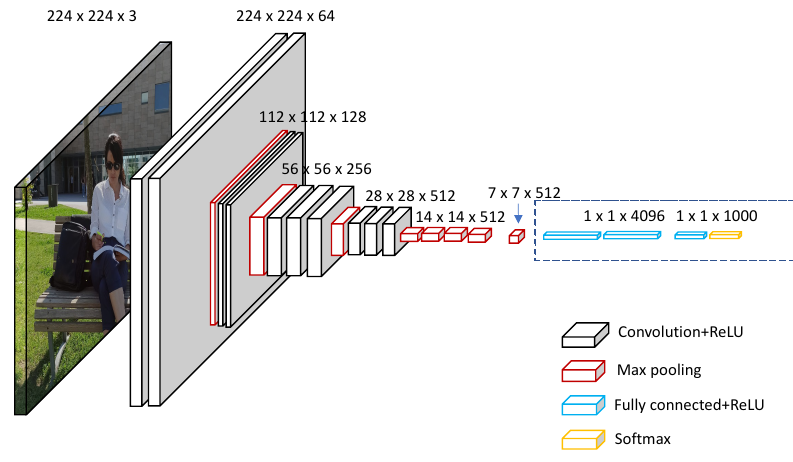
Figure 4. In this picture, the latest four layers of the CNN are shown, respectively, fully con- nected+ReLU layers and Softmax Activation Function. (Retrieved from